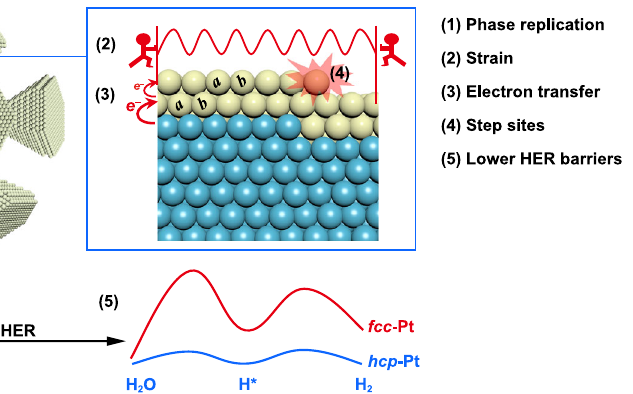
replication, strong compressive strains, layer-by-layer Ni – Pt electron transfer, and formation of surface step sites, which lower the energy barriers of the HER for improved catalytic